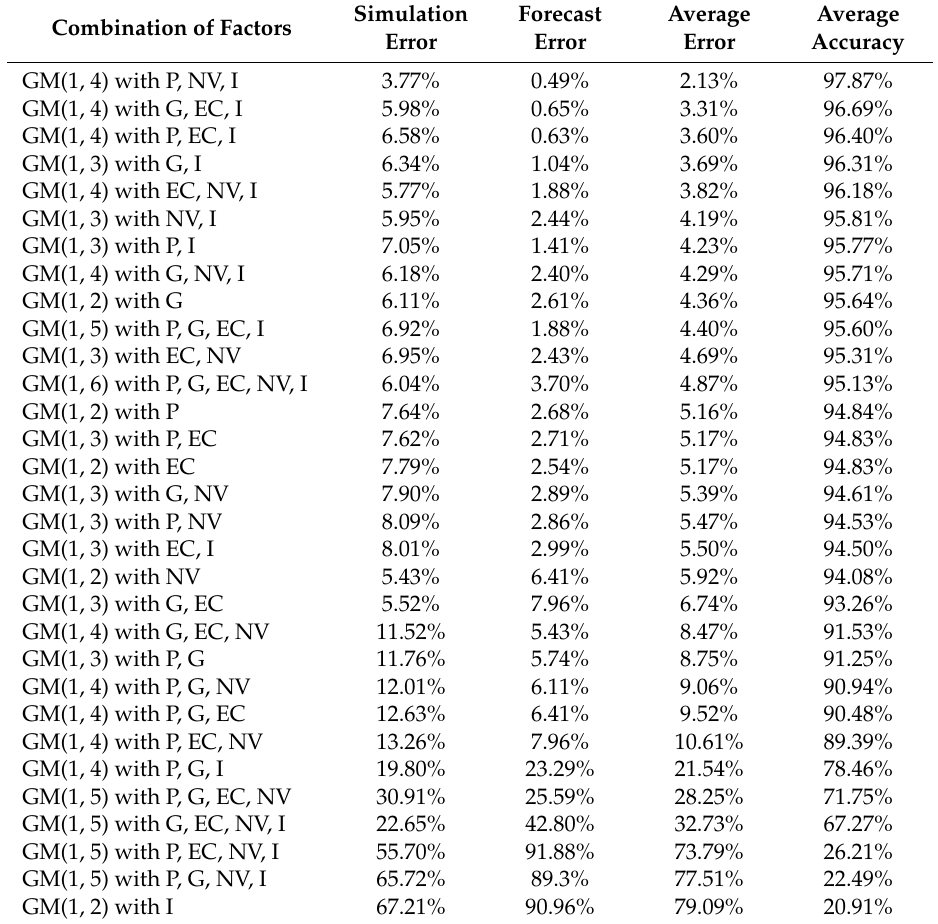
Table 11. Mean error and accuracy rate of the GM(1, N ) model during the period when Taiwan businessmen were moving overseas (i.e., trained with the data from 2011–2013 and tested with the data in